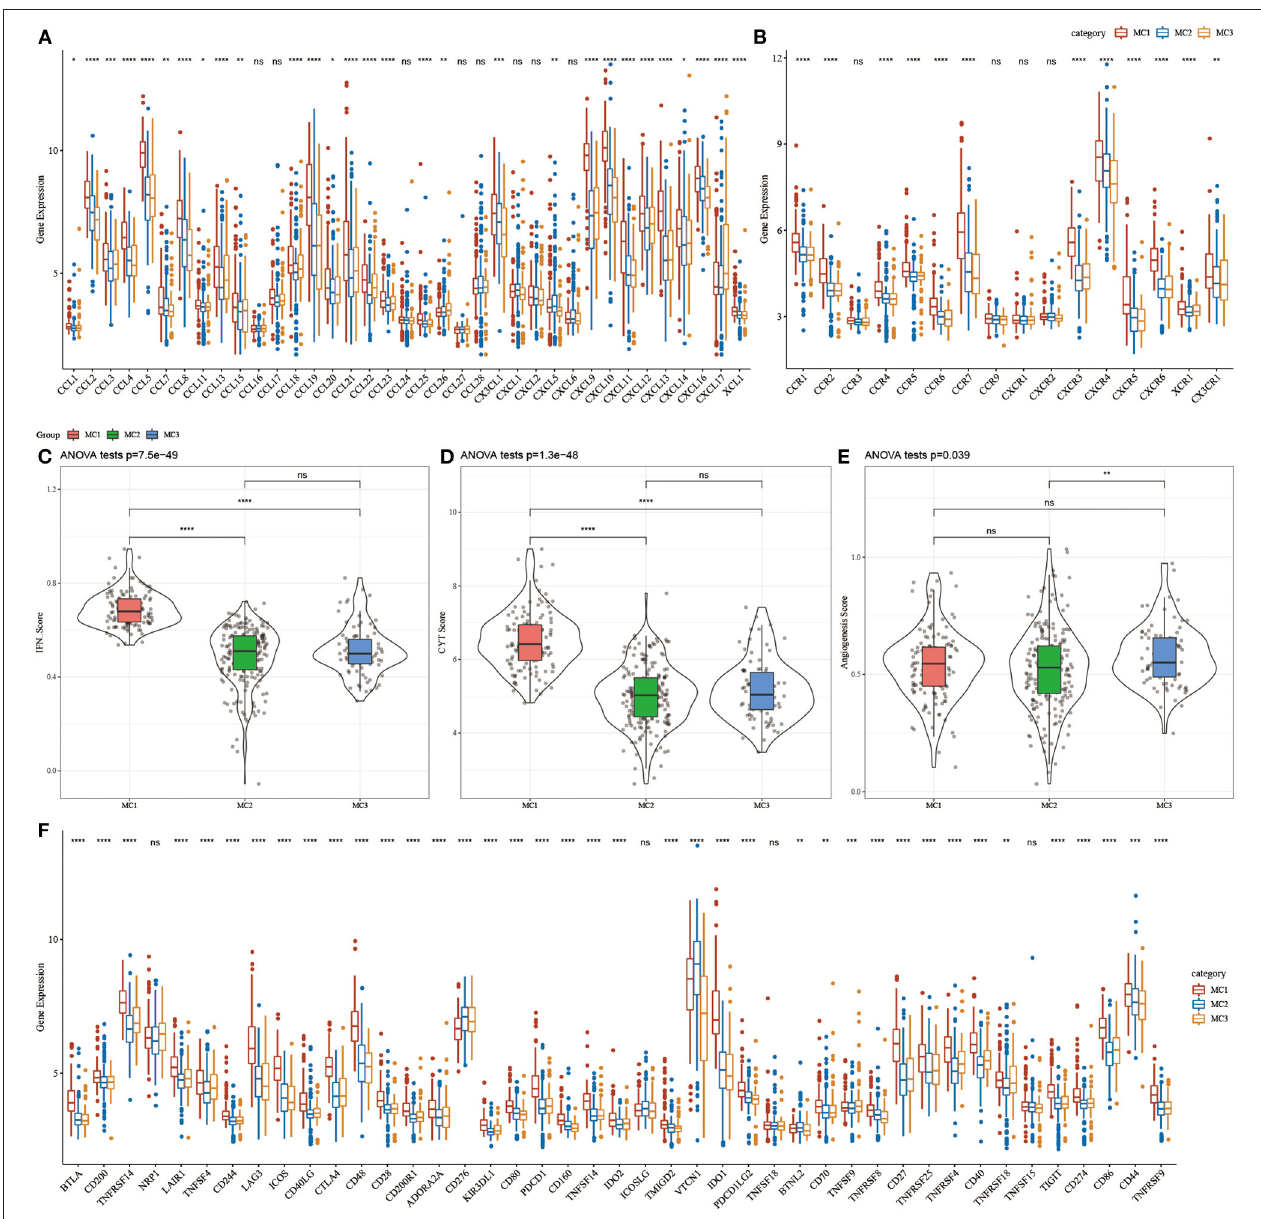
FIGURE 4 | (A) Differences in the expression distribution of chemokines in the RNASeq cohort; (B) Differences in the expression and distribution of chemokine receptors in the RNASeq cohort; (C) Differences in the distribution of IFN γ scores of different subtypes in the RNASeq cohort; (D) Different subtypes Differences in immune T cell lysis activity; (E) differences in angiogenesis scores in different subtypes; (F) differences in the expression and distribution of immune checkpoint genes in the RNASeq cohort; the significance of which is statistically tested using analysis of variance, * p < 0.05; ** p < 0.01, *** p < 0.001, **** p < 0.0001. ns, no